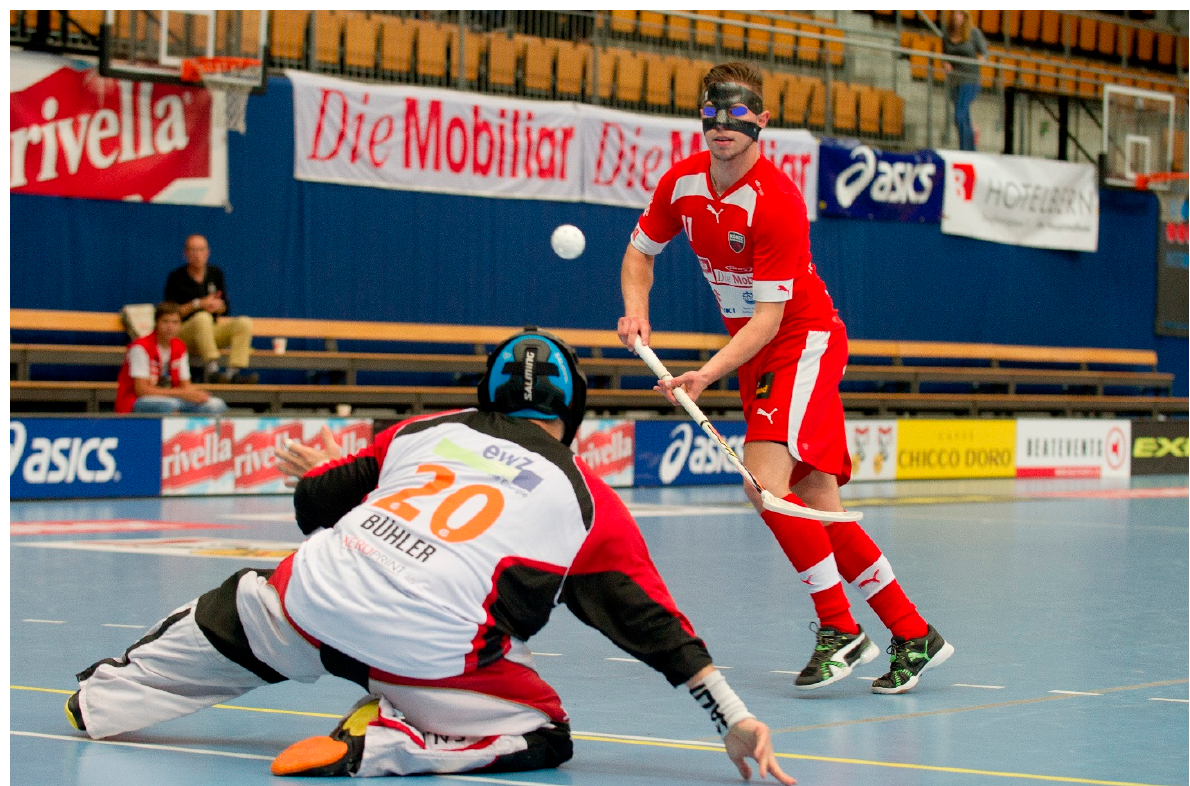
Figure 4. Example of nasal bone fracture mask (Photograph Fabian Trees).